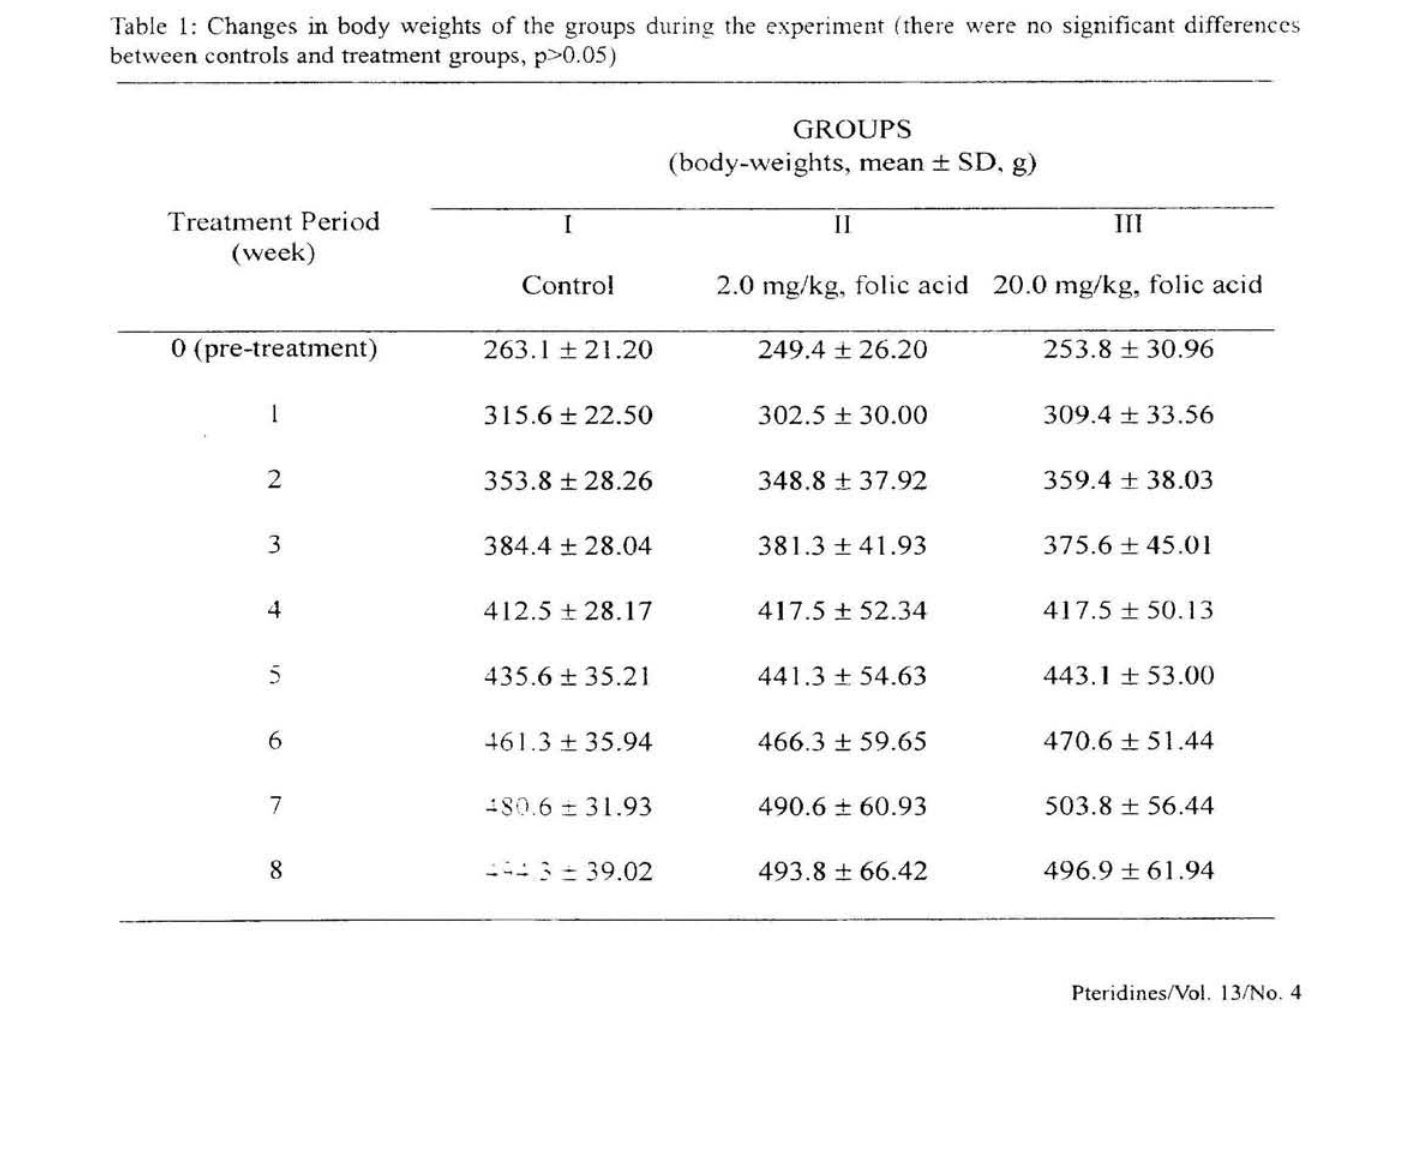
Table 1: Changes in body weights of the groups during the experiment (there were no significant differences between controls and treatment groups,